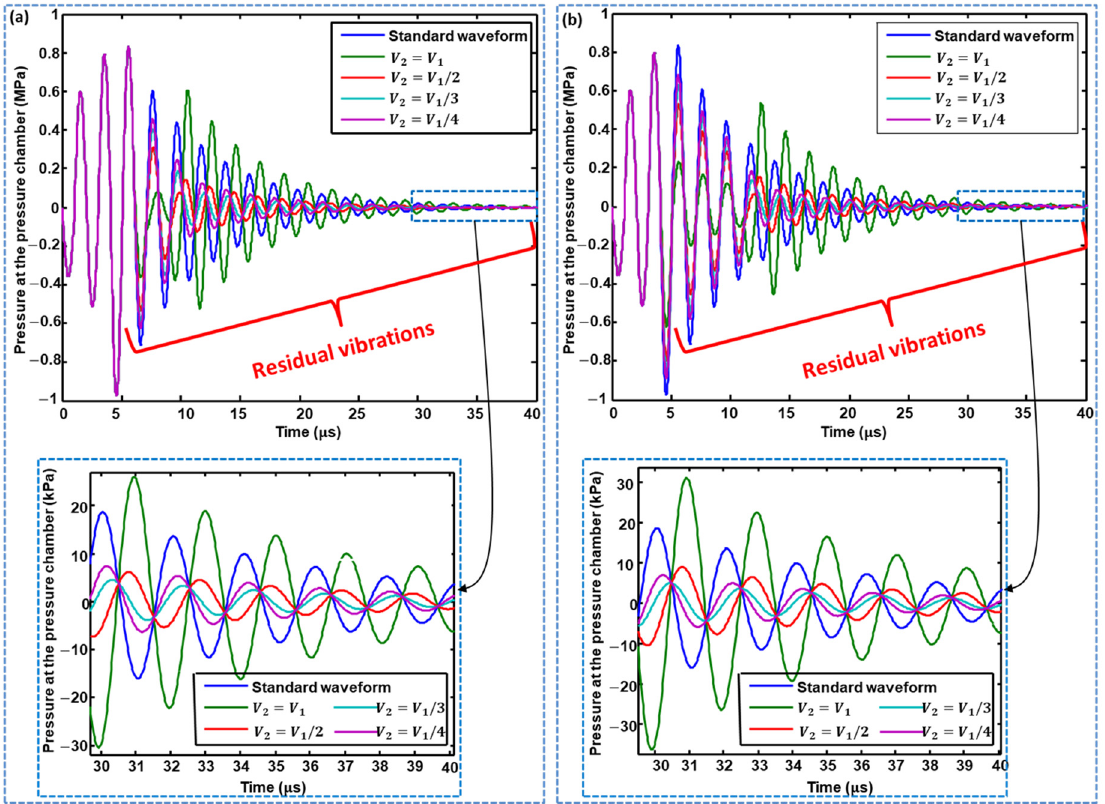
Figure 11. Effect of changing the voltage amplitude of the second pulse of: ( a ) Waveform 01; and ( b ) Waveform 02.